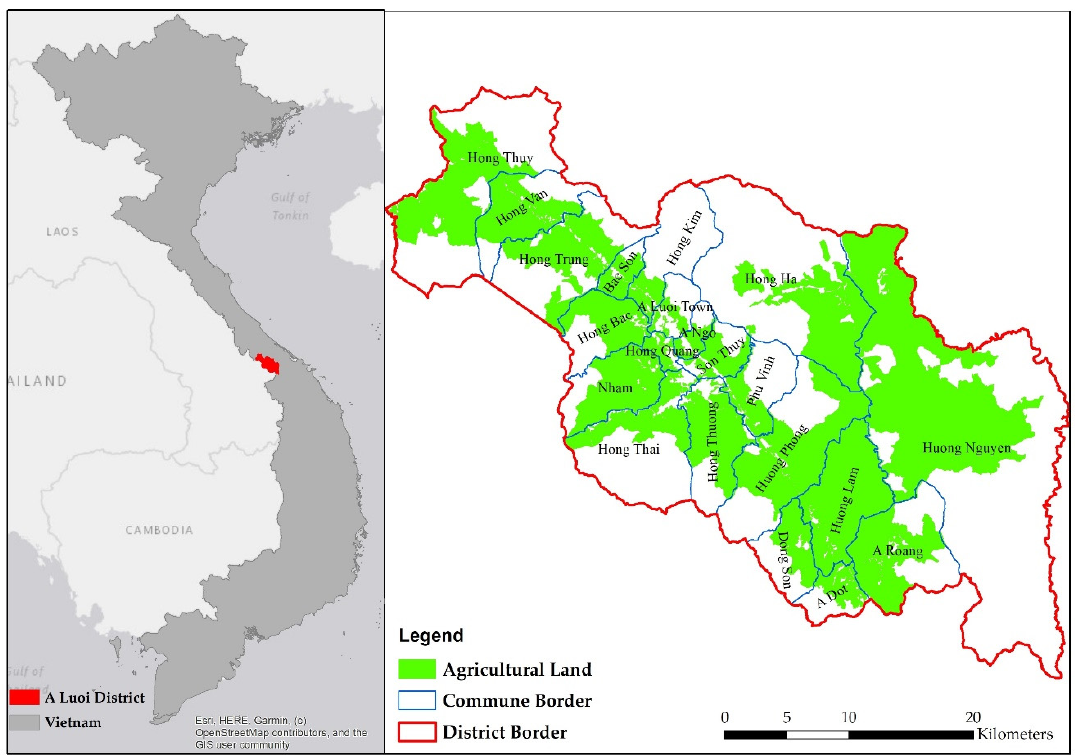
Figure 1. Research site and agricultural land use map.